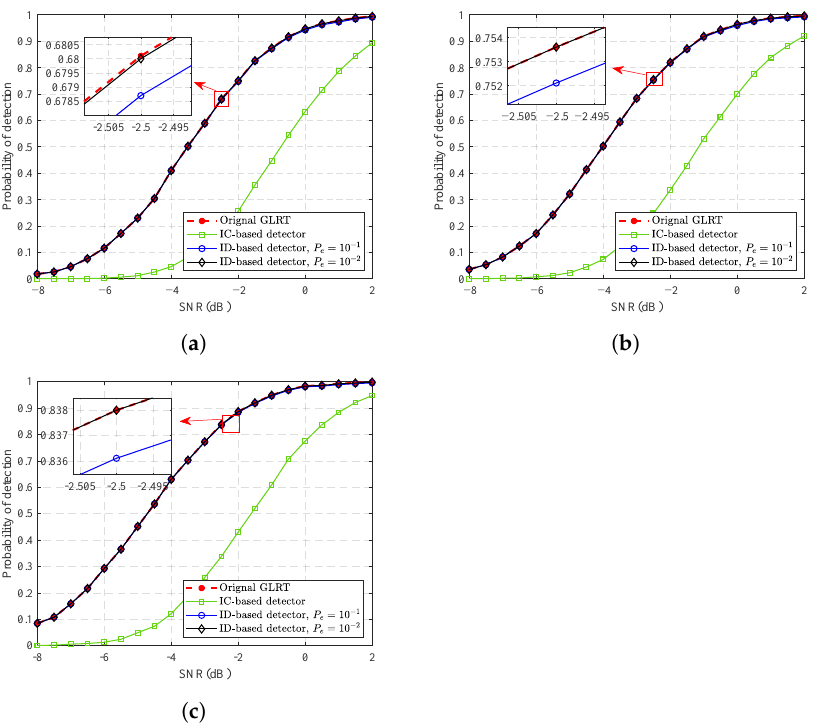
Figure 13. Probability of target detection for different P e when κ = 1. ( a ) P fa = 10 − 6 . ( b ) P fa = 10 − 5 . ( c ) P fa = 10 − 4